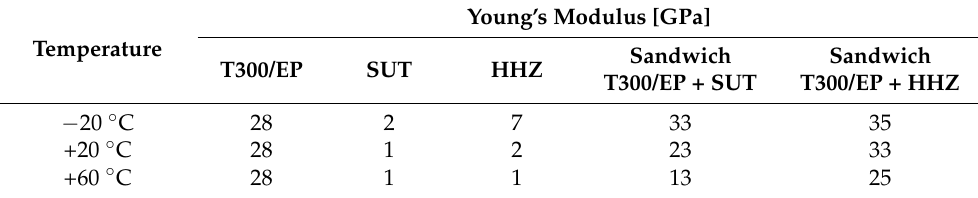
Table 1. Young’s Modulus averaged values for the composite laminate, for the pure damping layers and for the Sandwich laminates with SUT and HHZ at temperature of − 20, 20, and 60 ◦ C in untreated